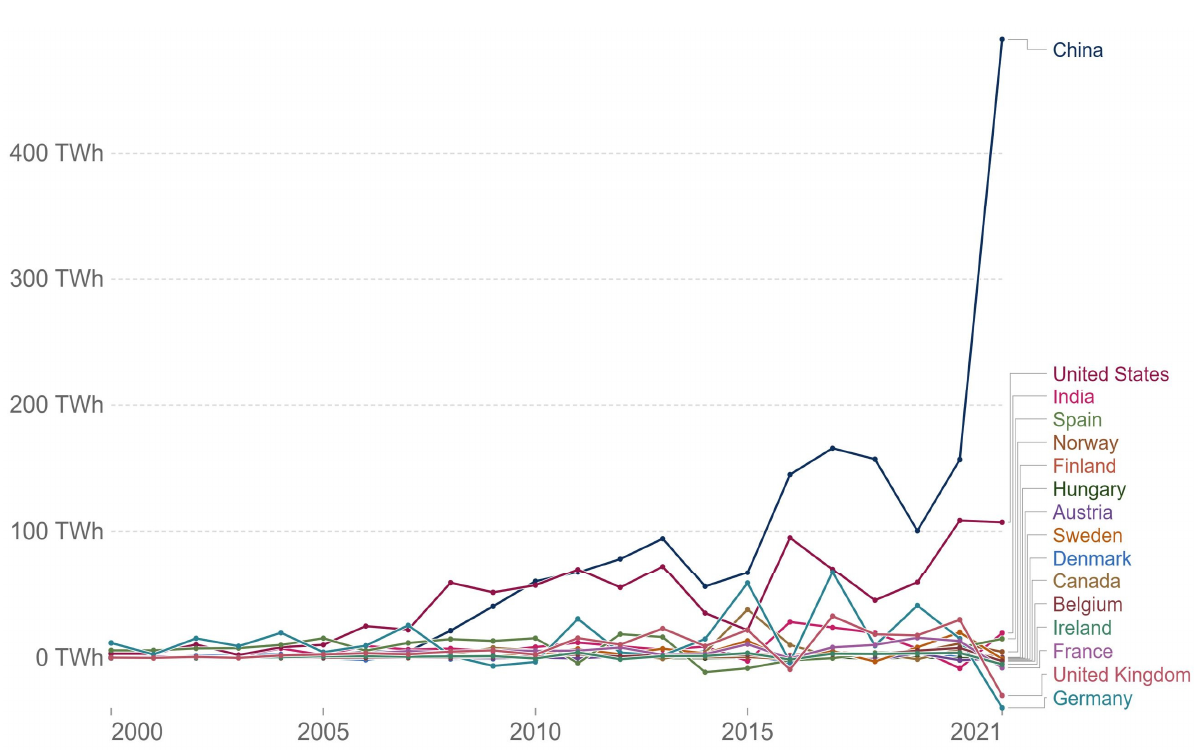
Figure 8. Annual change in solar energy generation across different country [41].